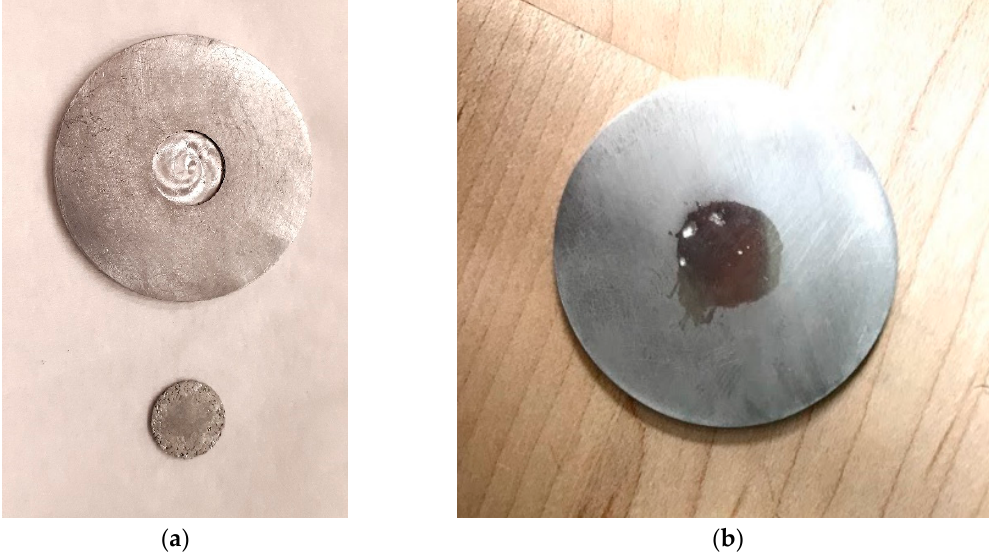
Figure 1. Target plate preparation. ( a ) A Ø35 mm × 1 mm aluminum backing plate with a Ø10 mm × 0.3 mm recess for the target material, and the pellet formed from zinc (150–300 mg) before fusing; ( b ) Zinc pellet fused to the backing plate before polishing.